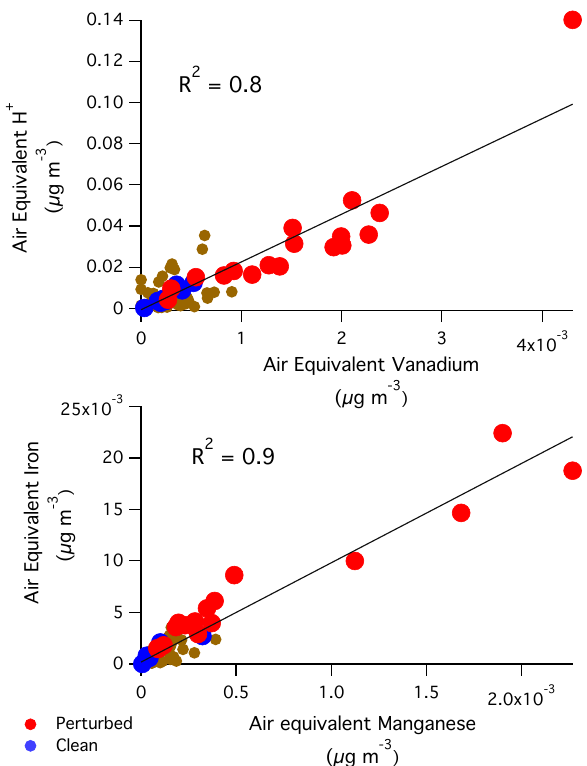
Fig. 8. Top – variation in air equivalent vanadium with respect to air equivalent hydronium concentrations for cloud water samples. Hydronium concentrations were calculated based on cloud water sample pH. Bottom – trend in manganese and iron concentrations in cloud water for measurements made during clean (blue) and per- turbed (red) days, respectively.